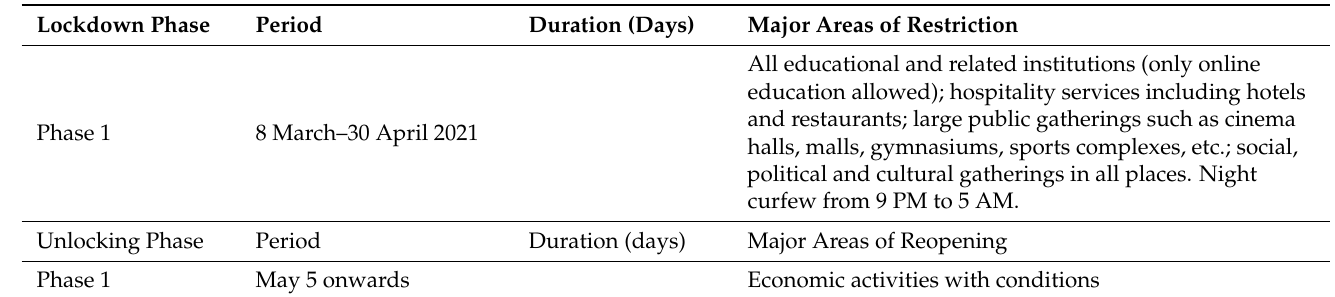
Table 2. Lockdown and unlocking phases in India, duration and areas closed/opened (excluding the unlocking phase in 2021 during wave